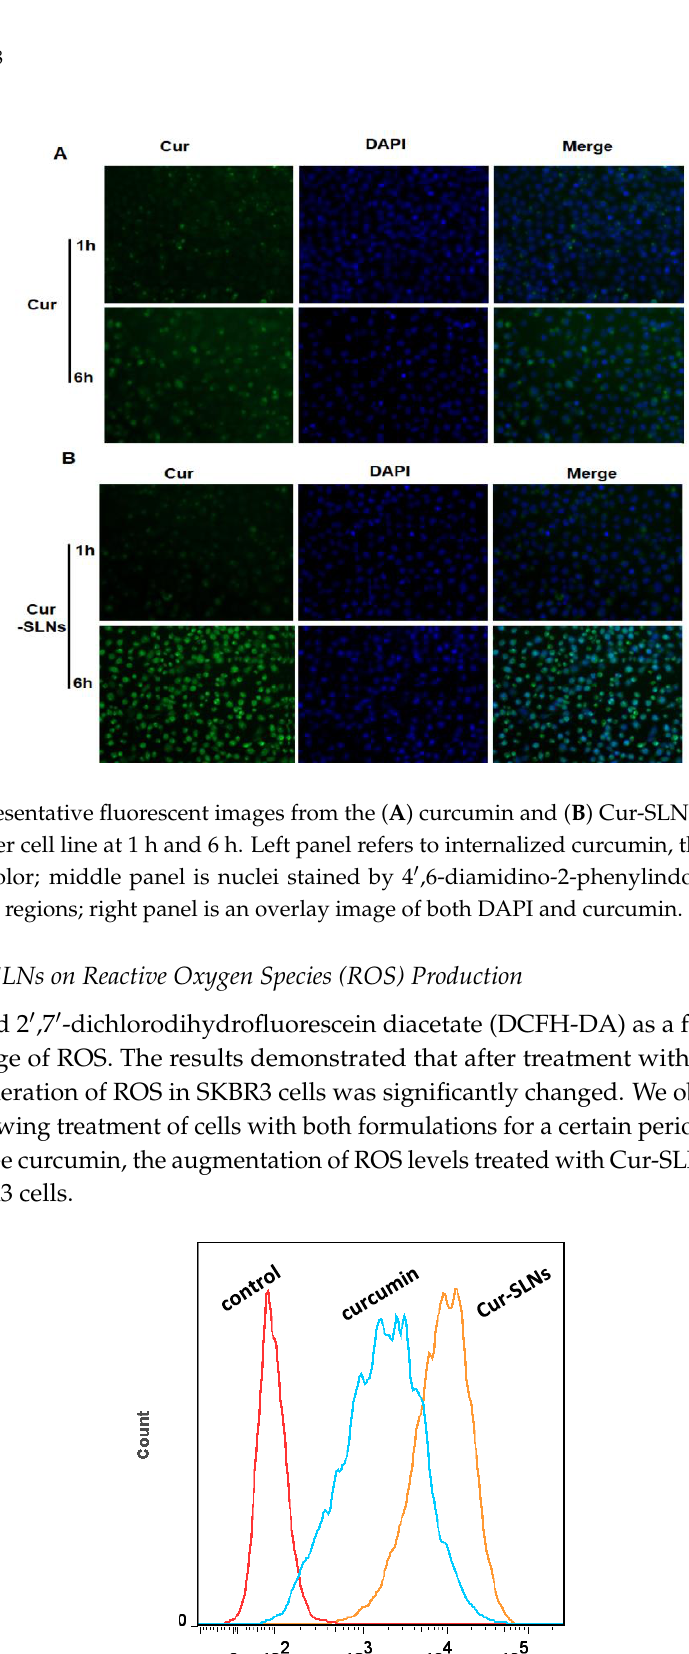
Figure 4. D ichlorodihydrofluorescein diacetate (DCFH-DA)/DCFH assay performed for the detection of Reactive Oxygen Species (ROS) generation by Cur and Cur-SLNs in SKBR3 cells.